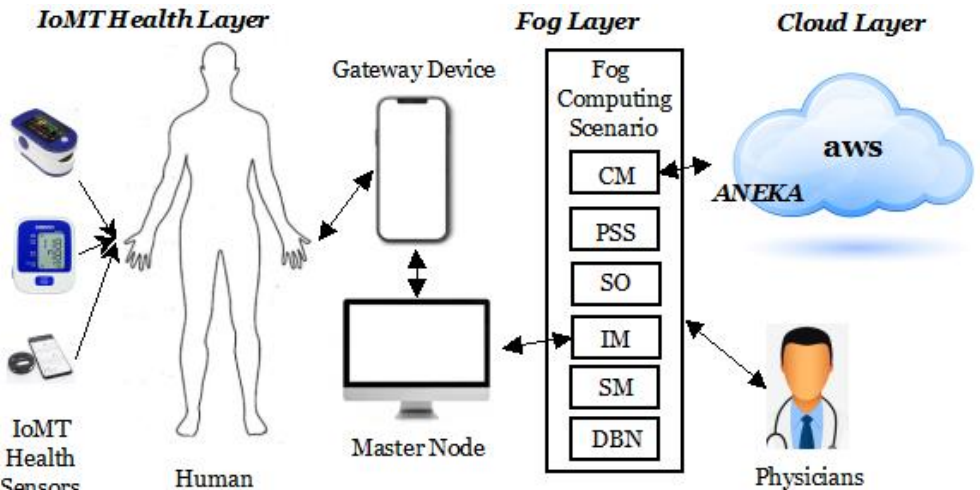
Figure 3. The architecture of FRIEND.